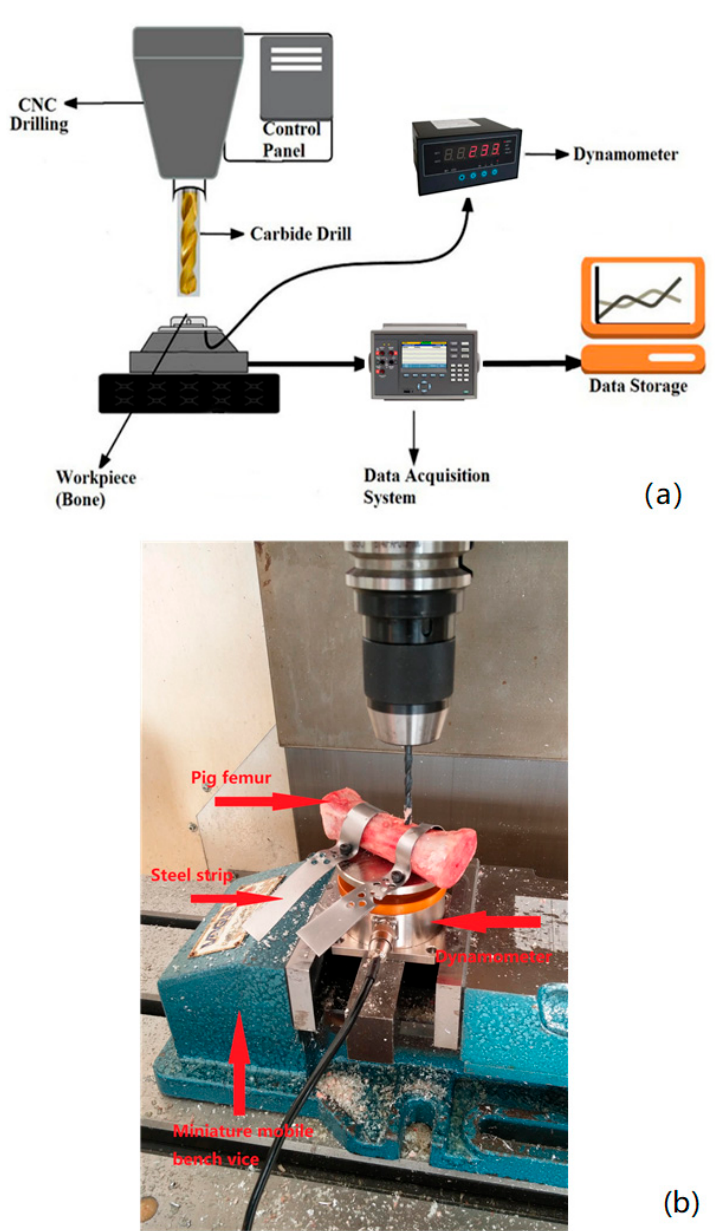
Figure 5. ( a ) Schematic diagram of the experimental device and ( b ) experimental setup.